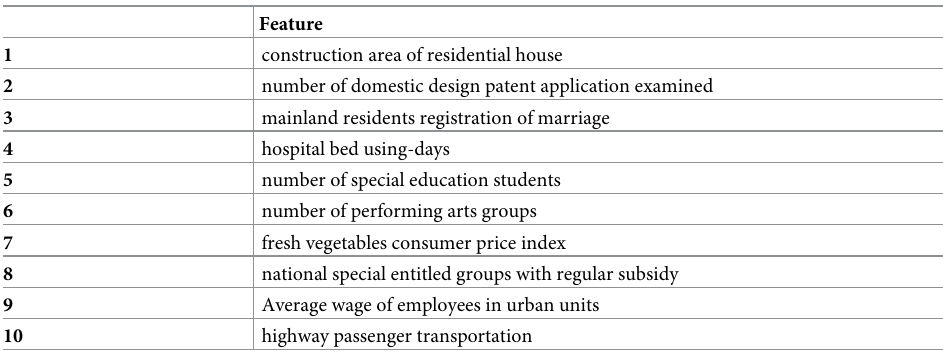
Table 14. 10 features by Wrapper Approach.